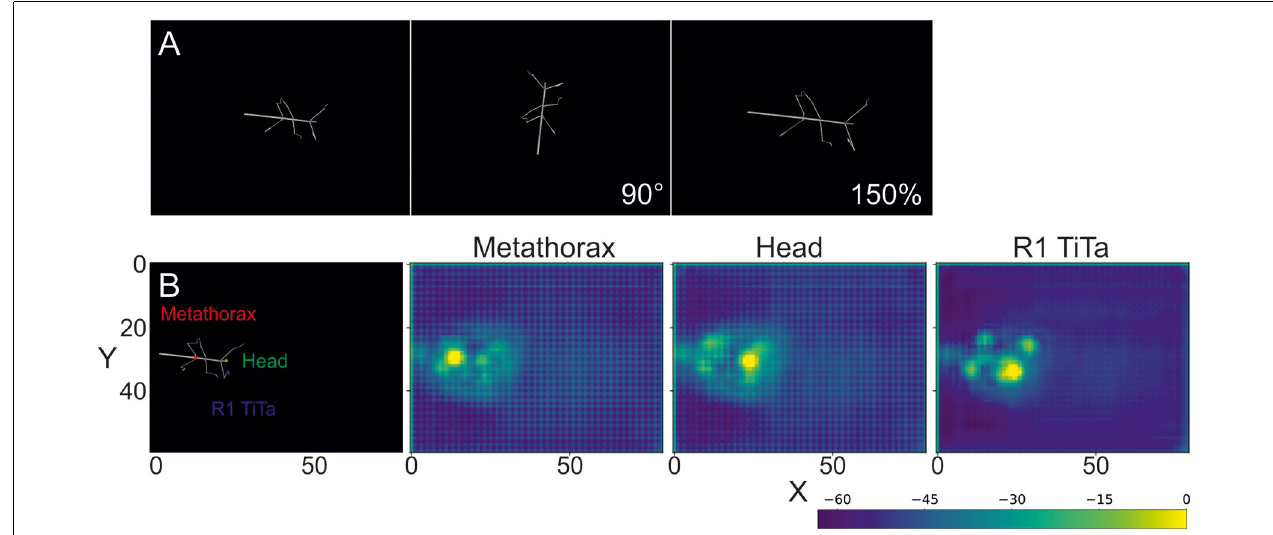
FIGURE 2 | Rendered frames and score maps of a synthetic video. (A) Top view of a stick insect whose posture was computed from experimental data, using forward kinematics. The body segments are represented as cylinders and the joints as spheres. As no texture was applied, the animal body has a smooth, gray surface. The above frames show the same posture modified by a rotation (90 ◦ ) and a scaling by 150%. (B) The color labels in the left frame correspond to the score maps of the deep neural network output on the right. The color code shows the confidence score of the network for a particular body feature to be located at that position. In the leftmost case the metathorax position was estimated (red dot in left frame). The middle and right images show score maps for the head (green dot in left frame) and the tibia-tarsus joint of the right front leg (blue dot in left frame), respectively. The axes correspond to the image coordinates in bins of 8 × 8 pixels. The score-map was log-transformed to improve visualization. Since the model outputs probability values in [0, 1], the log transformed values are negative. Warmer colors indicate higher